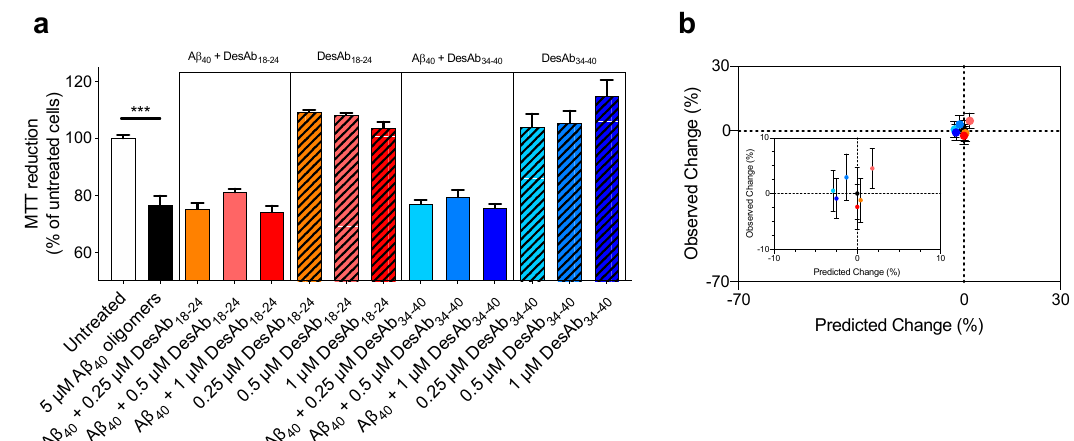
Figure 6. The interaction of the DesAbs with stabilized A β 40 oligomers does not change their toxicity. (a) Stabilized oligomers of A β 40 were resuspended in the cell culture medium at a concentration of 5 µ M and incubated in the absence (black plain bar) or presence of increasing concentrations (0.25, 0.5 and 1 µ M) of DesAb 18-24 (red plain bars) and DesAb 34-40 (blue plain bars) for 1 h at 37 ◦ C and then added to the cell culture medium of SH-SY5Y cells for 24 h. The cells were also treated with corresponding concentrations of the antibodies pre-incubated in the absence of oligomers (dashed bars with corresponding colors). Error bars indicate SEM of six replicates. The symbol *** indicates p < 0.001 (unpaired, two-tailed Student’s t -test). All conditions containing both antibodies and oligomers were not significantly di ff erent in comparison to cells treated with oligomers alone (individual antibody groups were compared by one-way ANOVA using Bonferroni’s multiple comparisons relative to cells treated with oligomers alone). (b) The wavelength of maximum ANS fluorescence as a probe of solvent exposed hydrophobicity and the Rayleigh ratios from SLS measurements as a measure of size were used to predict the change in MTT reduction caused by oligomers in the absence and presence of the various concentrations of DesAbs (Supplementary Table S1) as previously described [30]. The predicted values were plotted against the observed ones from (a). The formula predicts that the DesAb-mediated increase in both hydrophobicity and size of A β 40 oligomers does not significantly change the toxicity, as was observed